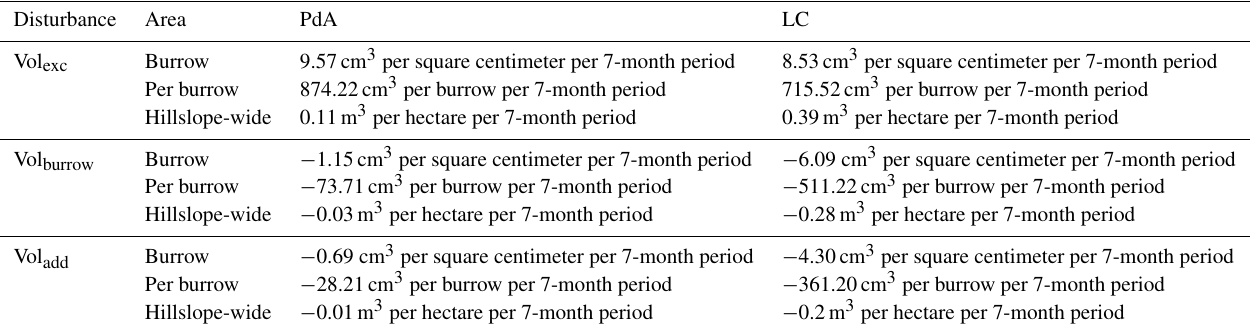
Table A4. Summary of the volume of redistributed sediment, according to area and disturbance type. Vol exc describes the volume of the sediment excavated by the animals. Vol burrow describes the volume of the sediment redistributed during rainfall events within burrows. Vol add describes the difference in redistributed sediment volume within burrows and burrow-embedded areas during